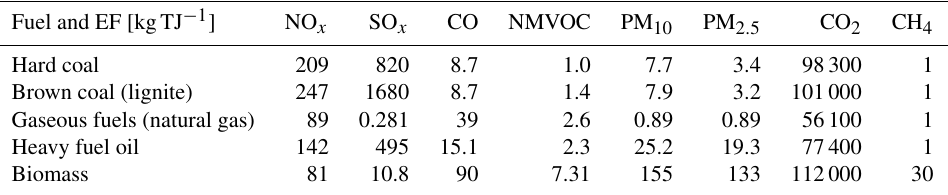
Figure 1. Representation of the spatial coverage of the datasets used to derive temporal profiles for the energy industry (a) , the manu- facturing industry (b) , road transport (c) and agriculture (use of fertilizers) (d) . For the energy industry, the legend indicates the different sources of information used: the European Network of Transmission System Operators for Electricity (ENTSO-E), the United States En- vironmental Protection Agency (US EPA), the International Energy Agency (IEA) and the Monthly Bulletin of Statistics (MBS). For the manufacturing industry, the legend indicates the sources of information used: the MBS and the MIX inventory (mosaic Asian anthropogenic emission inventory, Li et al., 2017). For agriculture, sources of information are also highlighted: Backes et al. (2016), Zhang et al. (2018), the MASAGE_NH3 (Magnitude And Seasonality of Agricultural Emissions model for NH 3 ) inventory (Paulot et al., 2014), US EPA (2019b), Skjøth et al. (2011) and Werner et al. (2015). Administrative boundaries are derived from GADM (2020). Table 4. Emission factors [kgTJ − 1 ] related to the energy industry per fuel type and pollutant. Values obtained from the EMEP/EEA 2016 emission inventory guidebook for the priority air pollutants (1.A.1 “Energy industries”, Tables 3-2, 3-3, 3-4, 3-5 and 3-7) and from the IPCC guidelines (Volume 2: “Energy”, Table 2.2) for greenhouse